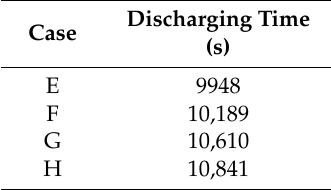
Table 3. Discharging time comparison.